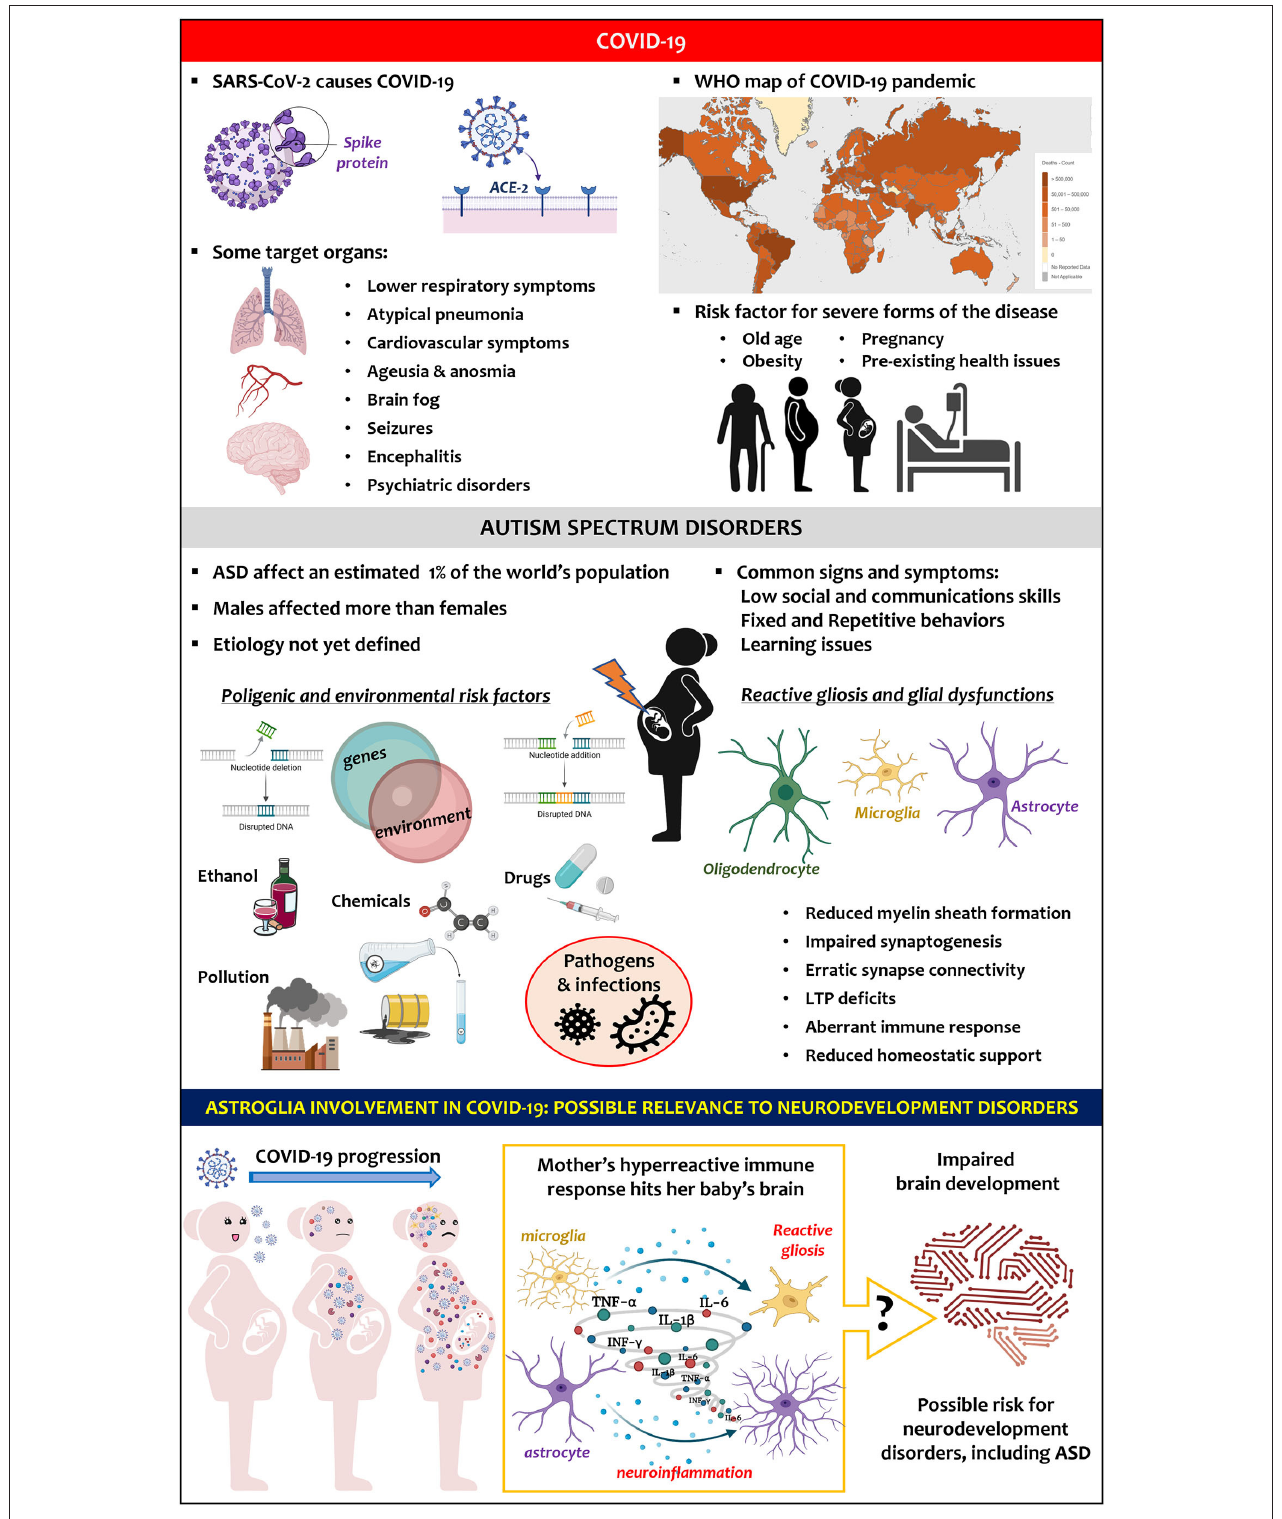
FIGURE 1 | Key facts on SARS-CoV-2 infection and COVID-19 pandemic (upper panel). Key facts on ASD (middle panel). Hypothesis (lower panel): COVID-19-induced hyperreactive immune response in pregnant women could trigger astroglia reactivity in the baby’s brain, altering its development and favouring neurodevelopment disorders, including